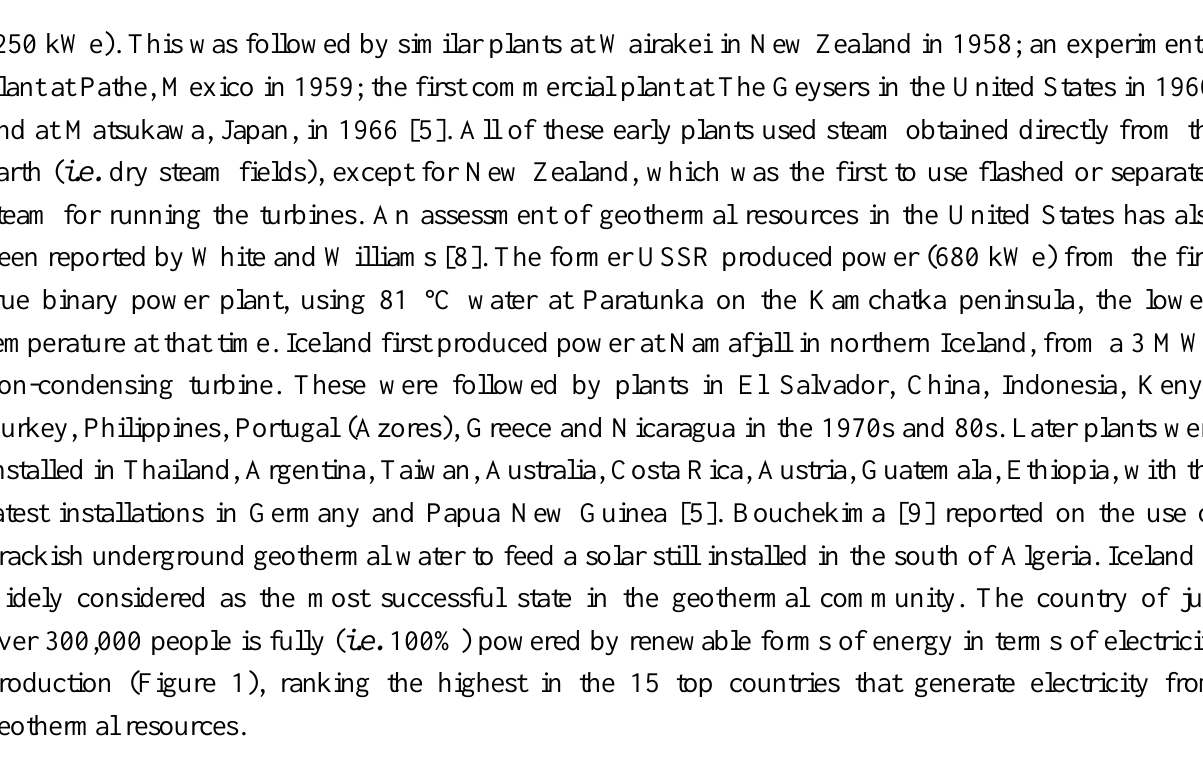
Figure 1. Share of total electricity generation from geothermal resources in the top 15 countries